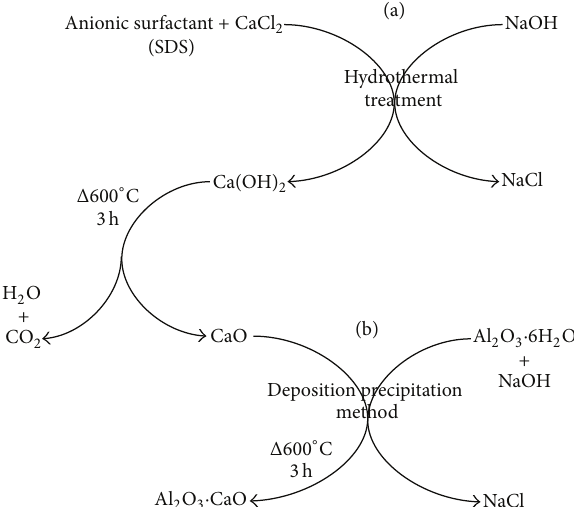
Figure 1: Experimental scheme for the synthesis of (a) CaO and (b) Al 2 O 3 ⋅ CaO